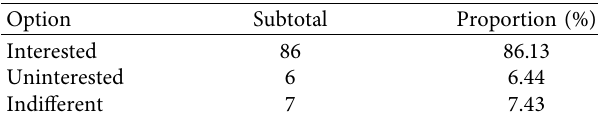
Table 2: Students’ interest in piano impromptu accompaniment courses after improvement.